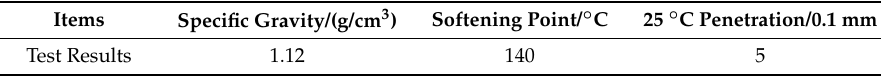
Table 3. Four Components of THFS.